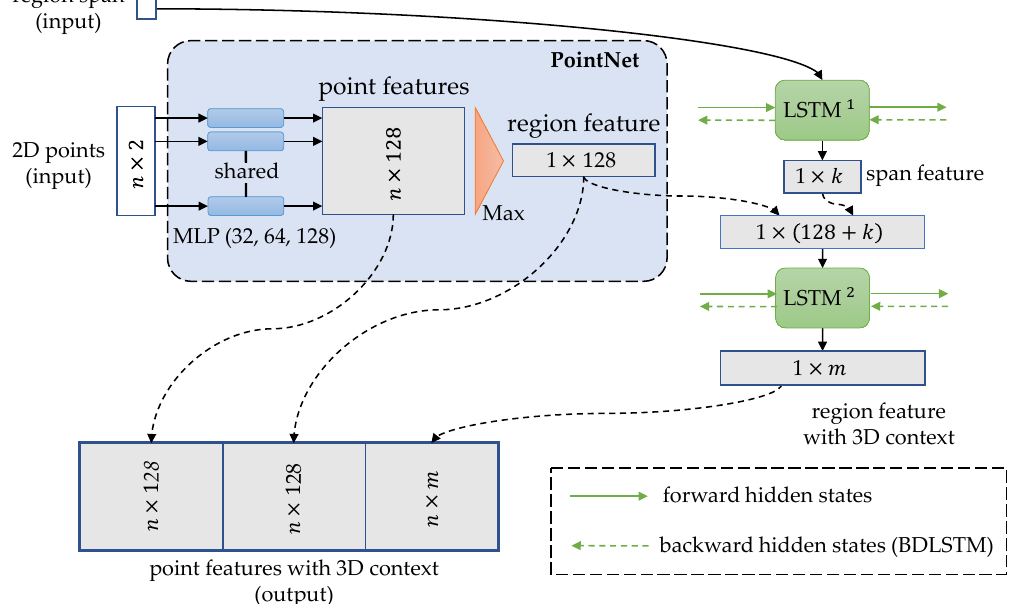
Figure 5. The architecture of SFN. In the PointNet, MLP denotes a multilayer perceptron, and batch normalization is applied to each layer of the MLP with ReLU. For feature fusion, both LSMTs are single hidden-layer. The hidden layer sizes of the LSTM 1 and the LSTM 2 are, respectively, 8 and 128 so that k and m are, respectively, 8 and 128 with the usage of UDLSTMs. Note that UDLSTMs are without backward hidden states. With the usage of BDLSTMs, outputs of the forward process and backward process are combined so that k and m are, respectively, 16 and